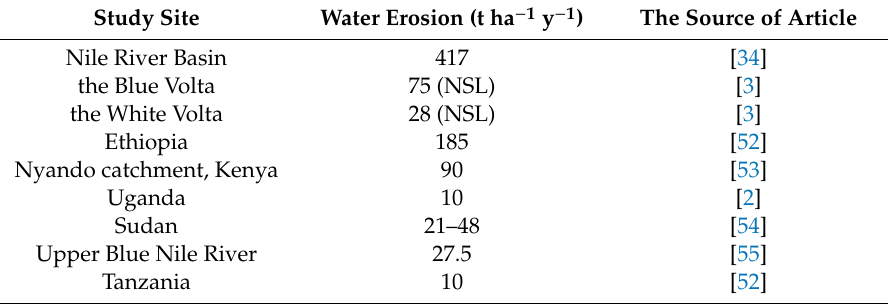
Table 4. Average water erosion for di ff erent regions in the Nile River Basin by di ff erent studies.